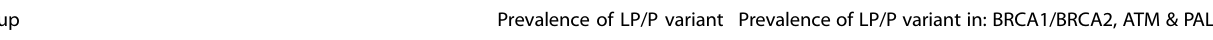
Table 2. The prevalence of mutations by various at risk